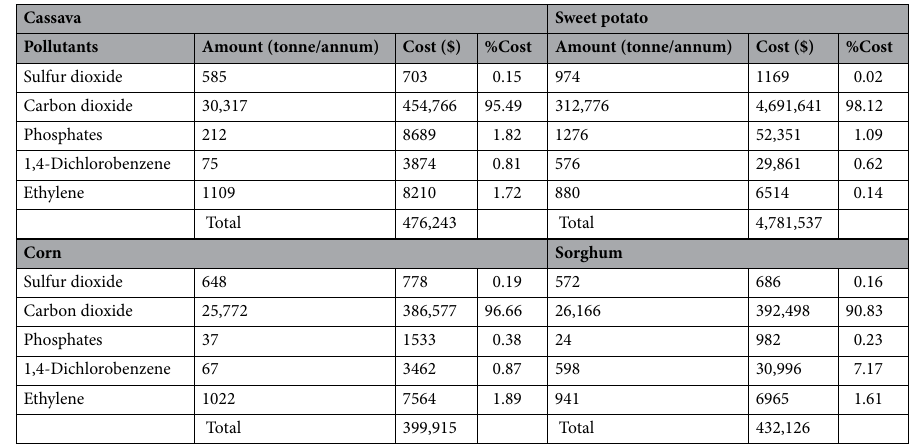
Table 11. Pollutants and cost of emissions.